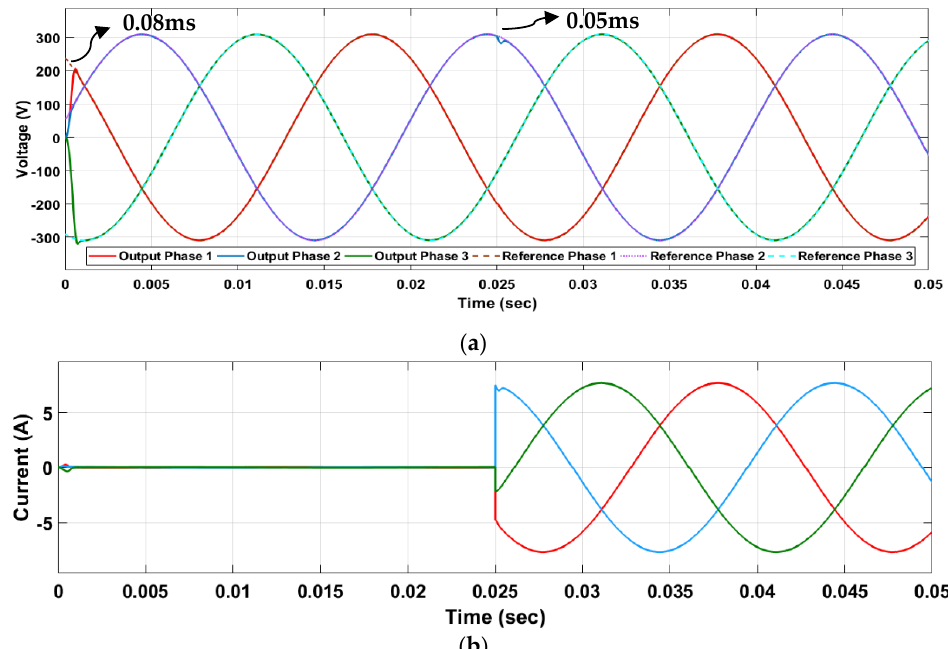
Figure 9. ( a ) Proposed C-ERL-RSS, output voltage-reference tracking trajectory and voltage regulation. ( b ) Proposed C-ERL-RSS, load current-step response under extreme load variations.